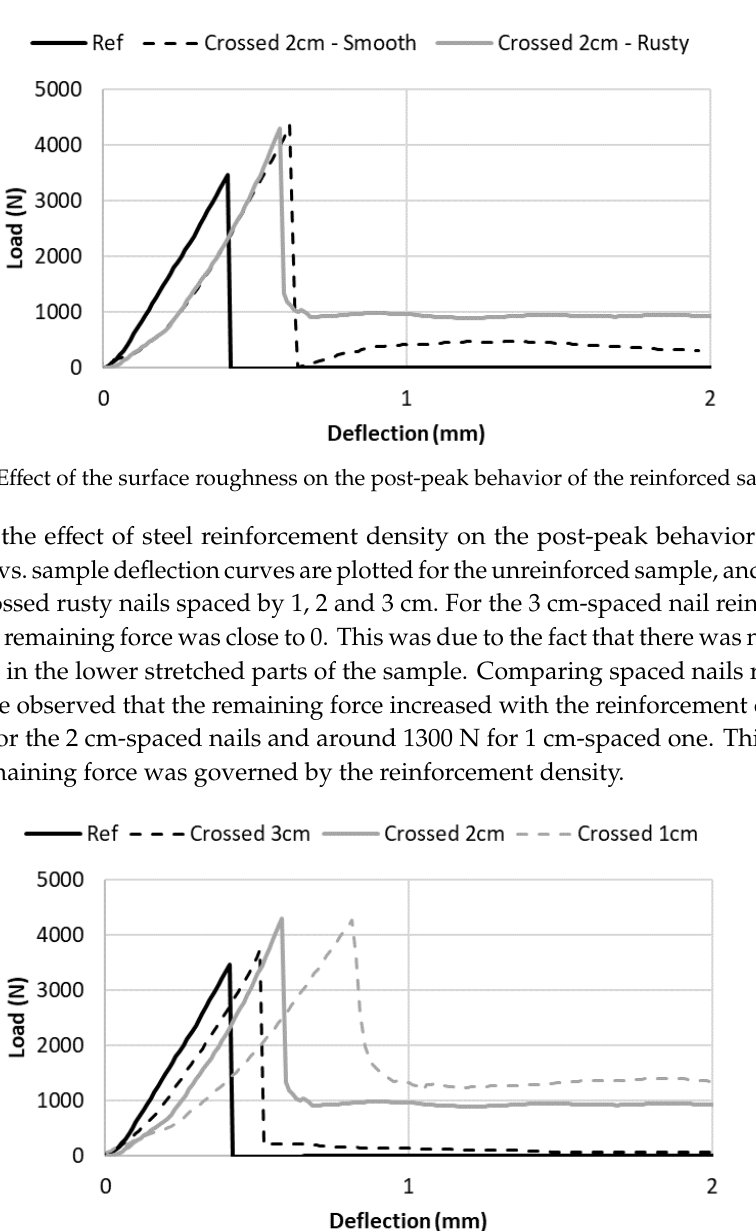
Figure 9. Effect of the nail’s configuration on the post-peak behavior of the reinforced samples. 4.3. Possible Durability Issues and Steel Corrosion One major drawback of this method is linked to the presence of steel within a cementitious matrix: with time, the cement matrix carbonation process will lead to a reduction of pH or penetration of chloride which will result in steel corrosion. Steel corrosion is a very known pathology of conventional